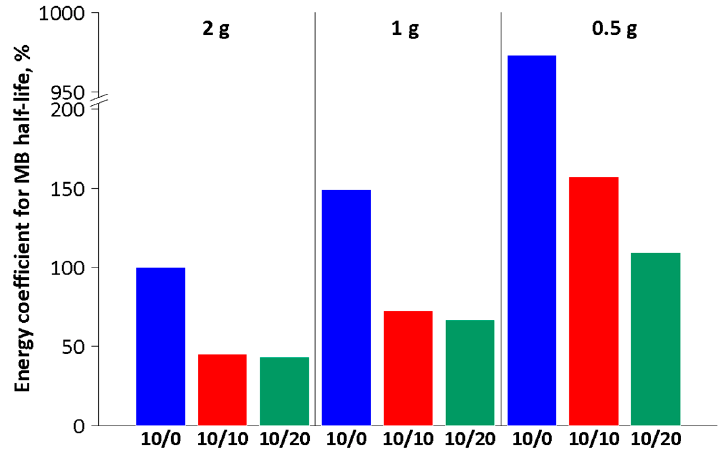
Figure 10. Relative energy demand of the mixing process to achieve a 50% dye reduction, depending on the mixing mode (Note: Ordinate axis was broken at 200%).